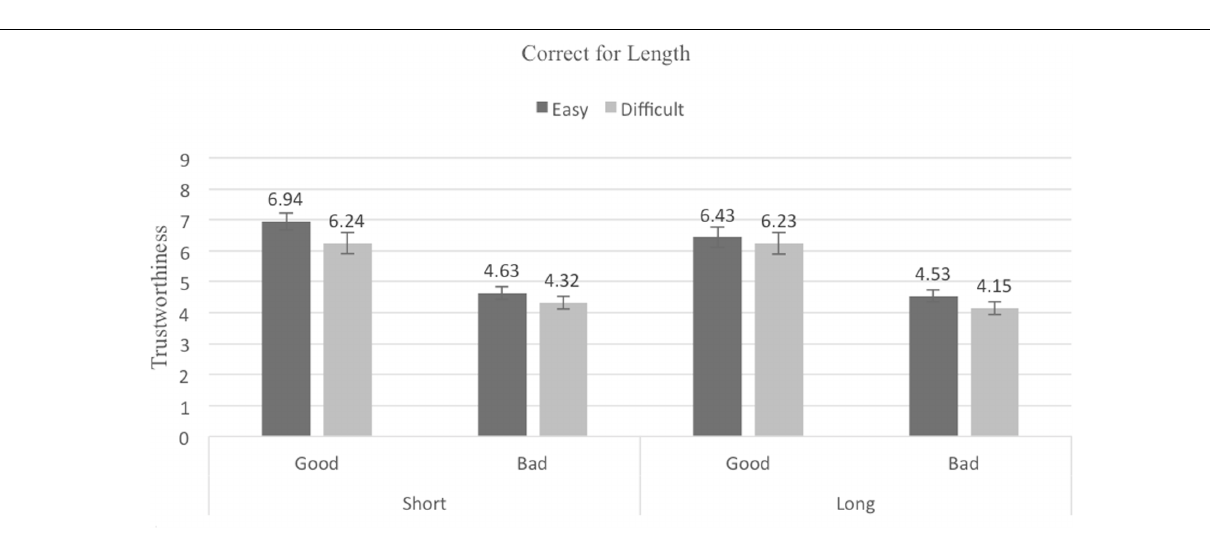
FIGURE 5 | Average trustworthiness ratings in the Length-correction condition of Experiment 4; error bars denote standard